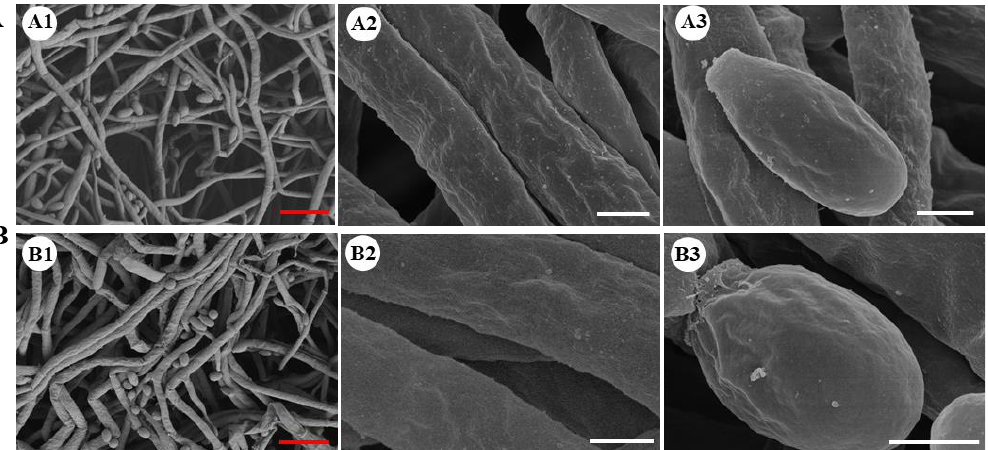
Figure 3. Hyphae and conidia of WT ( A ) and Δ Cmhyd4 ( B ) strains observed by SEM. A1 and B1 showed the overview of the hyphae and conidia; A2 and B2 showed the surface of the hyphae; A3 and B3 showed the surface of the conidia. Bars: A1, B1 = 1 μm; others = 10 μm.